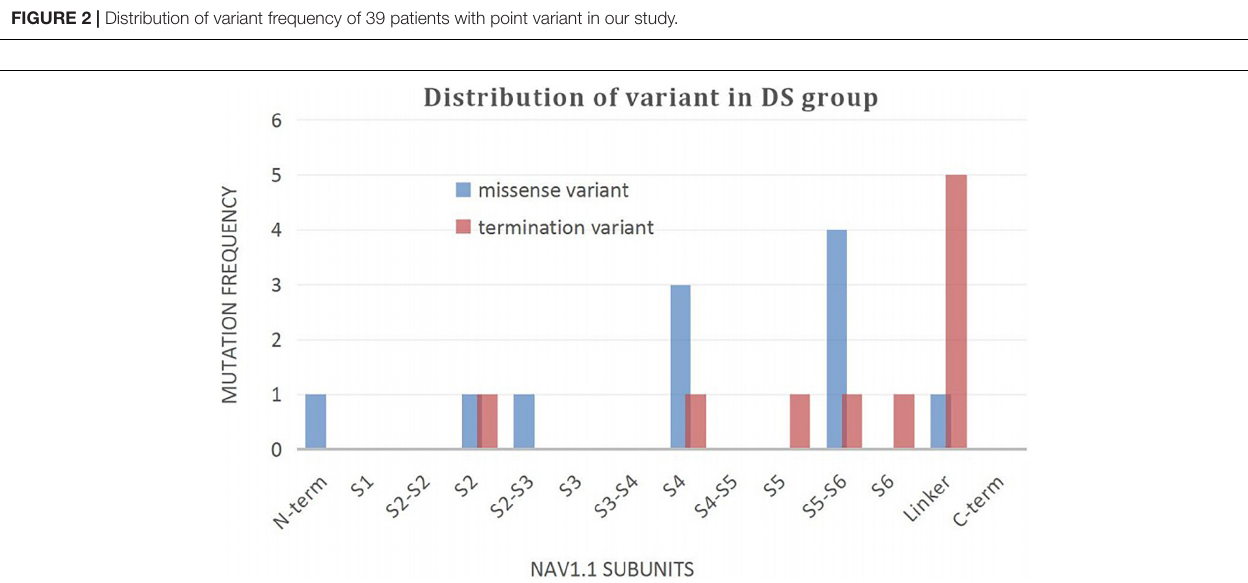
FIGURE 3 | Distribution of variant in DS